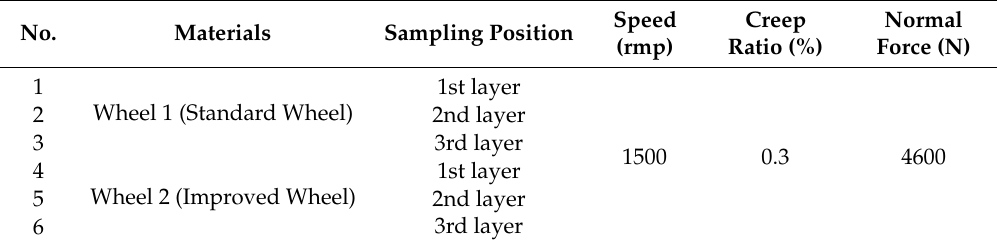
Table 3. Experimental parameters for all